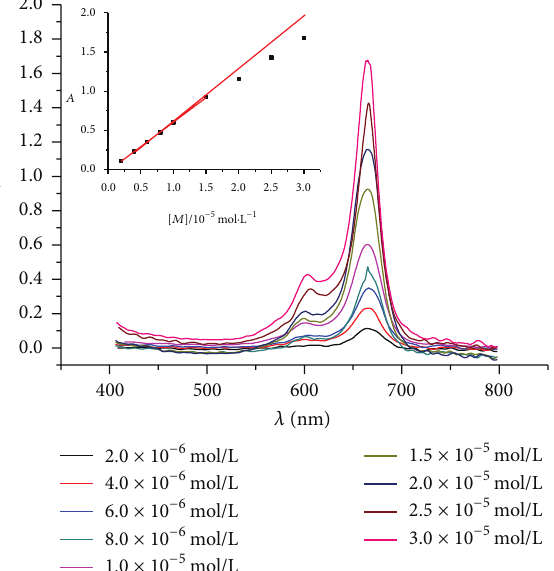
Figure 6: Absorbance of cobalt sulfonated phthalocyanine in 5% sodium hydroxide solution. (The inset is the relationship between the absorbance at maximum absorption wavelength and the con- centration.)